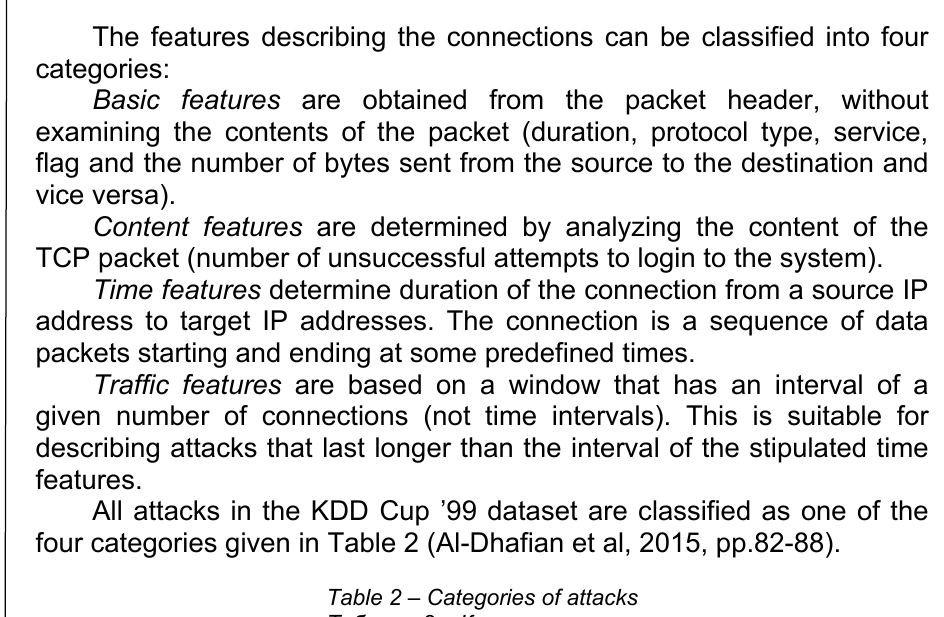
Table 2 – Categories of